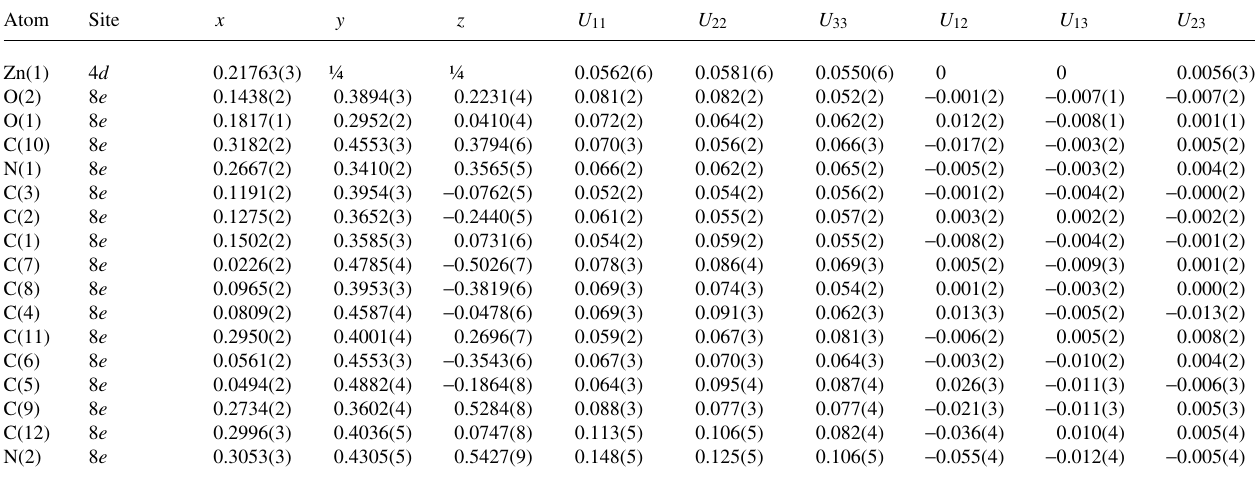
Table 3. Atomic coordinates and displacement parameters (in Å 2 )